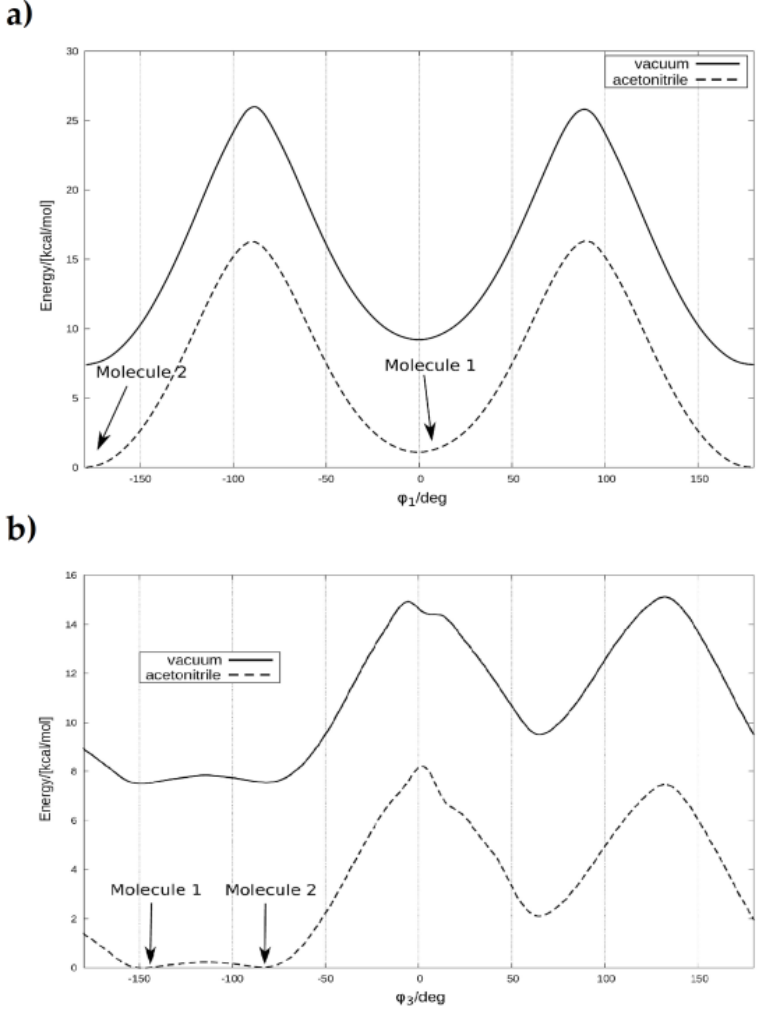
Figure 2. The DFT torsional potentials of CDHB for ϕ 1 ( a ) and ϕ 3 ( b ) coordinates. Torsional angles are defined as ϕ 1 = C2-C1-C7-O4, ϕ 3 = C7-O4-C8-C9, for the numbering of atoms see Table S1.